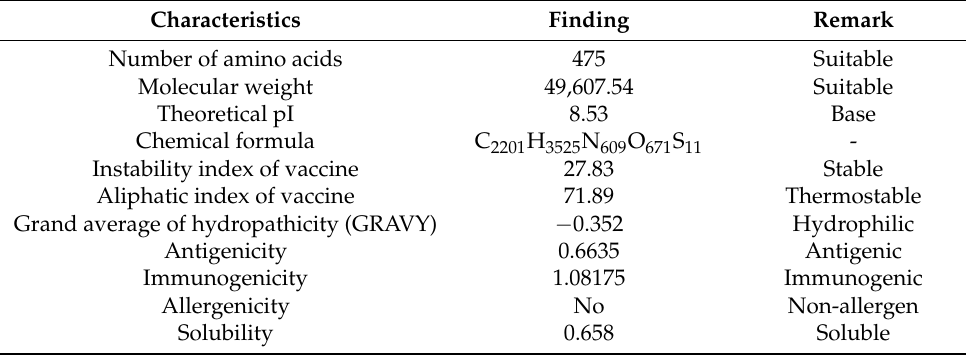
Table 6. Antigenicity, allergy, and physicochemical features of the construct.